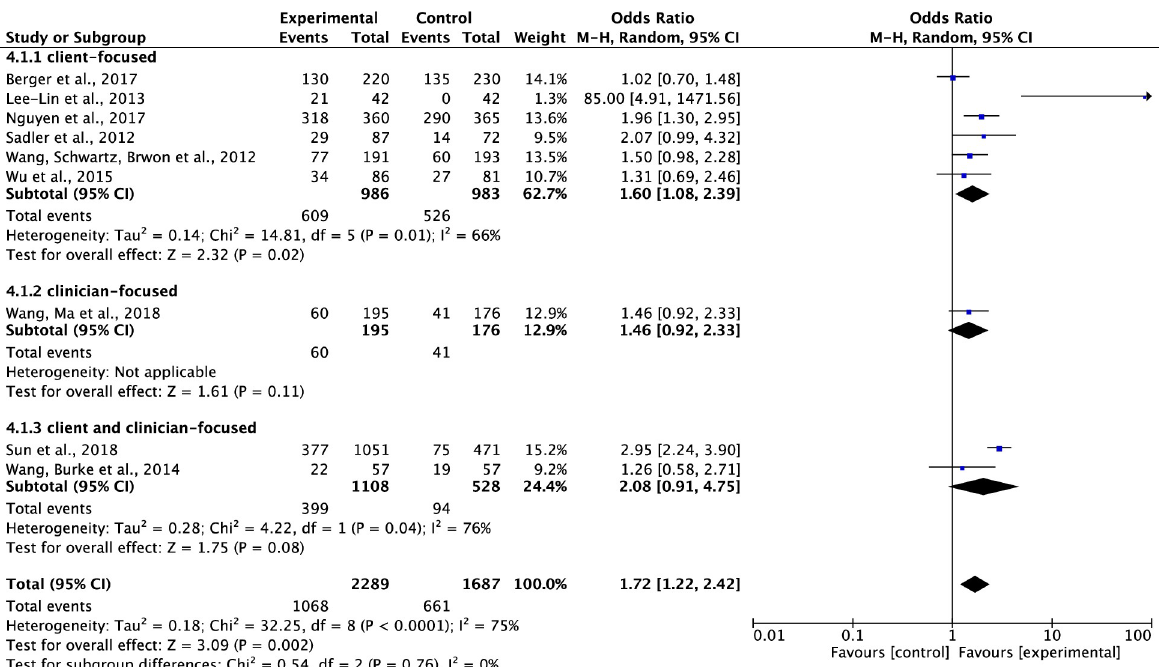
Fig 9. Forest plot of client-focused VS. clinician-focused VS. client and clinician-focused interventions on participants’ completion of cancer screening.